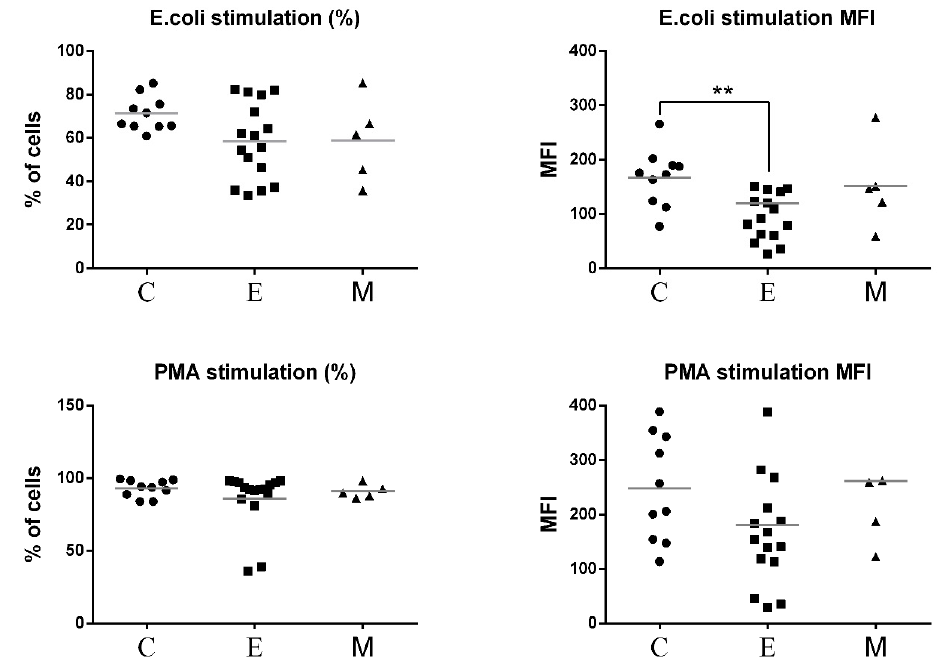
Figure 8. Flow cytometric example dot plots showing the percentage of granulocytes stimulated to undergo respiratory burst in control and experimental female dogs. Heparinized whole blood from control and experimental animals was divided into four test tubes. The samples were incubated with the washing solution (negative control), E. coli bacteria (opsonizing stimulus), PMA (strong stimulus), or fMLP (weak stimulus) and incubated with dihydrorhodamine 123 in a water bath at a temperature of 39 °C. After incubation, red blood cells were lysed, and the DNA staining solution was added to exclude aggregation artifacts of bacteria or cells. The percentages of granulocytes stimulated to undergo respiratory burst (conversion of dihydrorhodamine 123 to rhodamine 123) were gated.